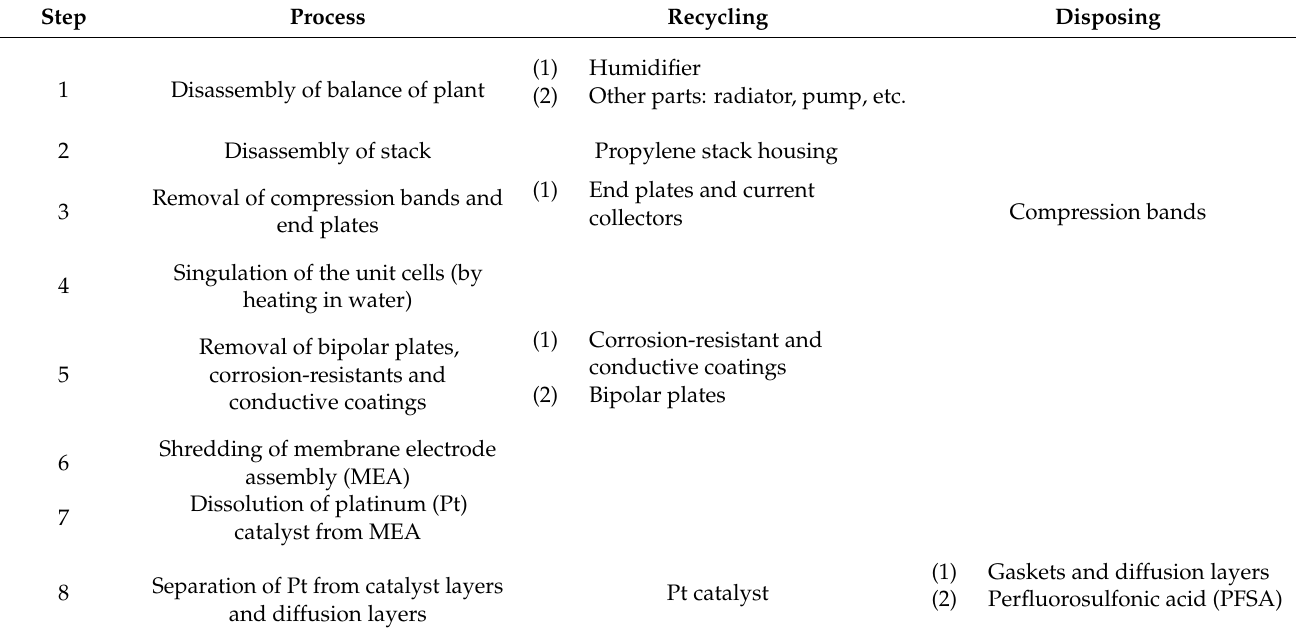
Table 2. The recycling process of PEMFCs at the end of life